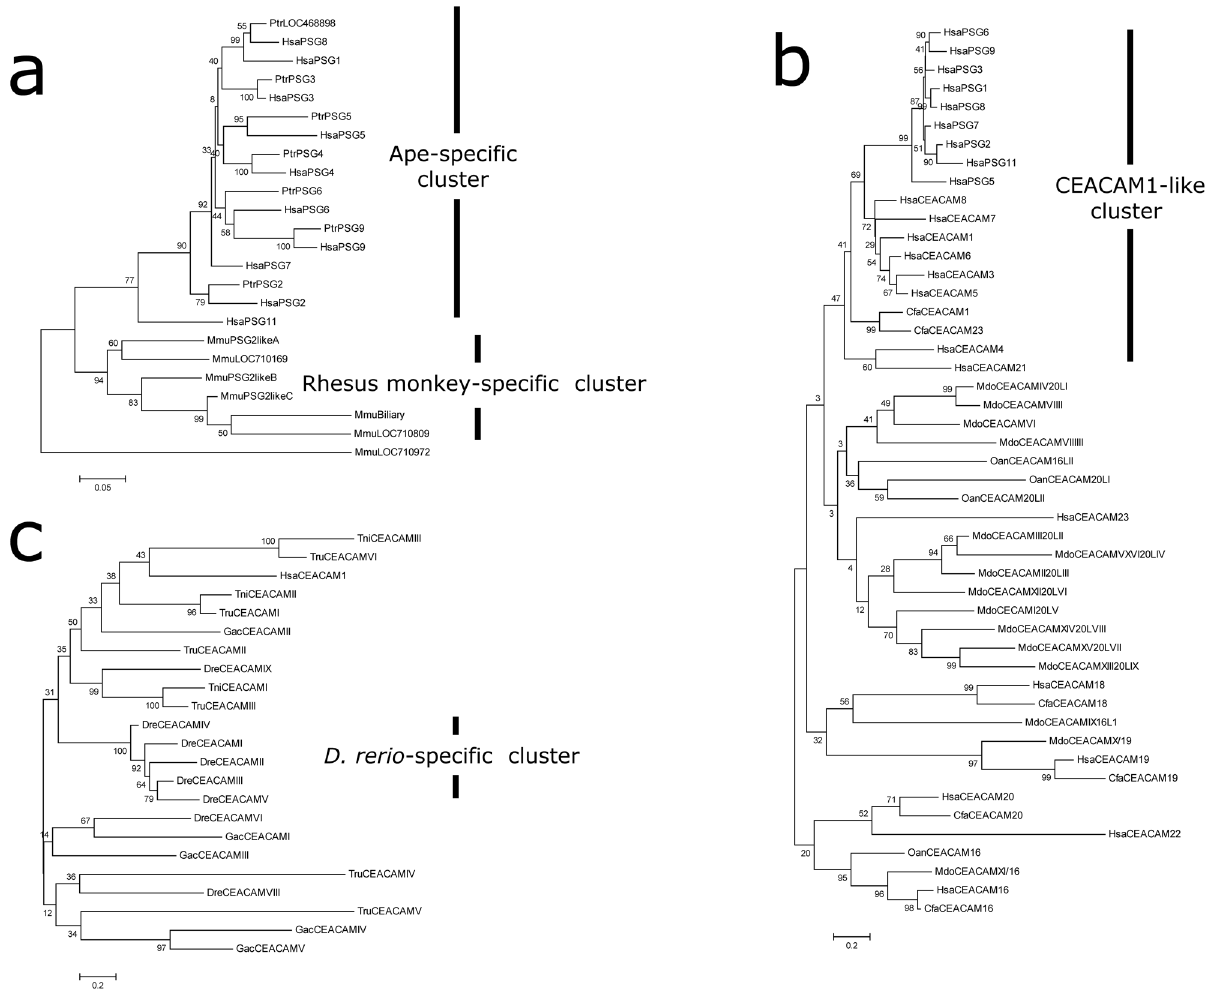
Figure 2. Analysis of CEACAM/PSG family gene evolution based on the Neighbor-Joining method. a) Phylogenetic tree of PSG subfamily genes from human, chimpanzee, and Rhesus monkey. A Rhesus monkey-specific cluster and an ape-specific cluster are indicated by vertical bars on the right. Potential pseudogenes, including human PSG10, chimpanzee LOC468901, and Rhesus monkey LOC709992, were excluded from the analysis. Human, Hsa; Chimpanzee, Ptr; Rhesus monkey, Mmu. b) Phylogenetic tree of 48 CEACAM family proteins from human, dog ( C. familiaris ), opossum ( M. domestica ), and platypus ( O. anatinus ). The analysis involved 48 protein sequences. There were a total of 2119 positions in the final dataset. The human CEACAM1-like cluster is indicated by a vertical bar on the right. The CEACAM16 and 20 homologs appear to diverge from other family members before the separation of eutherian, metatherian and prototherian mammals. Human, Hsa; dog, Cfa, opossum, Mdo; platypus, Oan. It is important to note that the bootstrap values for basal lineages in this tree are extremely low. The interpretation of this Neighbor-Joining tree has to be cautious . c) Phylogenetic tree of teleost CEACAM homologs. Twenty-three CEACAM proteins from D. rerio , G. aculeatus , T. rubripes , and T. nigroviridis were analyzed. A D. rerio -specific cluster is indicated by a vertical bar on the right. The robustness of the tree was assessed by 1,000 bootstrap replicates, and the percentage of replicates is shown next to the branches.